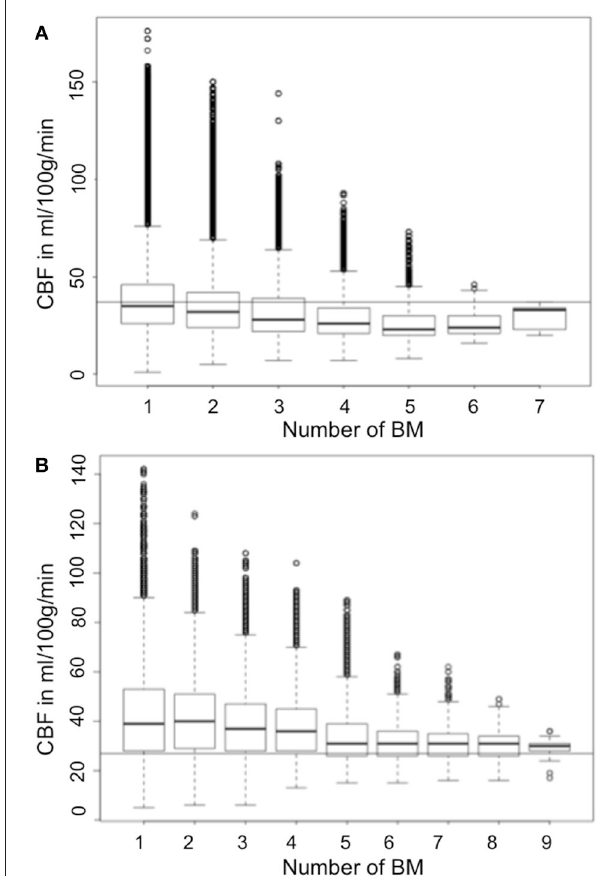
FIGURE 4 | Boxplot showing the median CBF (y-axis) according to number of BM (x-axis) in relation to the median CBF (A) supra- and (B) infratentorial (continuous horizontal